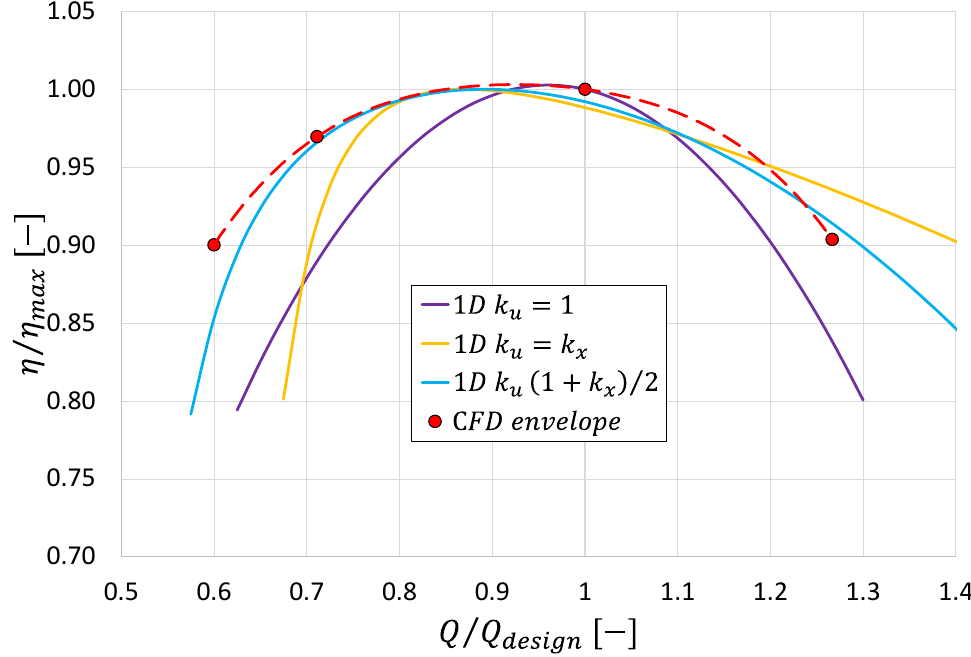
Figure 14. Normalized efficiency curves versus the fraction of the design flow rate under the constant design net head: the 1D theory results compared with the CFD envelope curve.